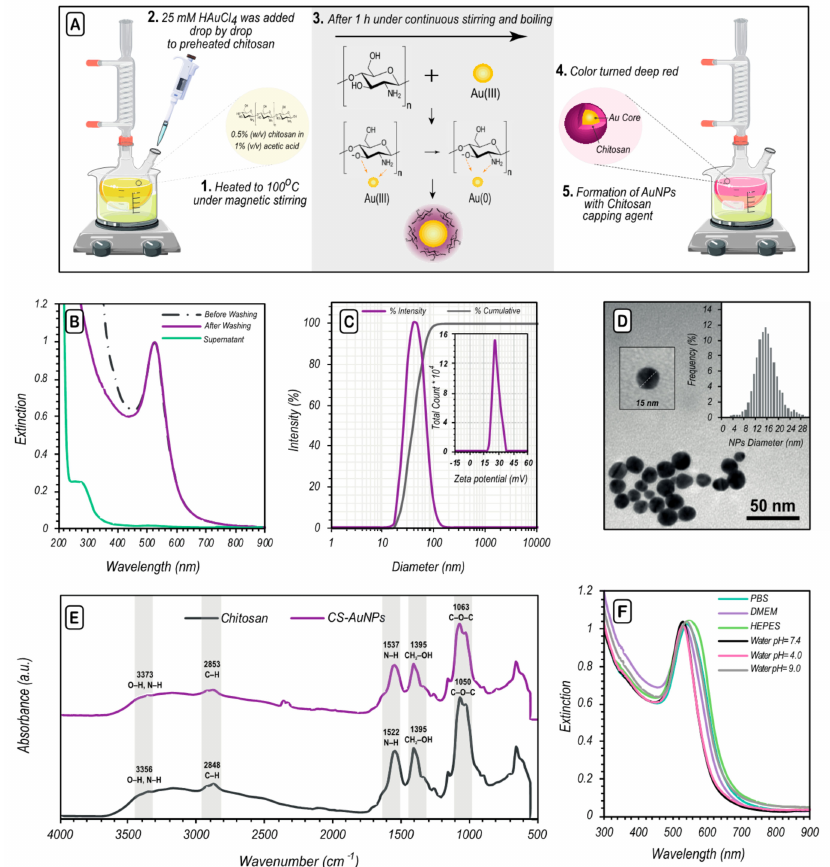
Figure 1. Characterization of Chitosan-capped AuNPs (CS-AuNPs), ( A ) Schematic representation of the synthesis of AuNPs using chitosan as a capping and reducing agent. ( B ) UV-Vis spectra of CS-AuNPs before and after washing of unreacted chitosan by centrifugation. ( C ) Representative hydrodynamic size distribution of CS-AuNPs, measured by DLS. The grey curve is the corresponding cumulative distribution. The inset shows the zeta potential distribution. ( D ) TEM images of CS- AuNPs confirming the formation of spherical nanoparticles, which were faceted (inset). The size dis- tribution from measuring >800 nanoparticles revealed an average particle core size of 15.0 ± 0.5 nm. ( E ) FTIR spectra of Chitosan and CS-AuNPs, confirming successful capping of the NPs by Chitosan. ( F ) UV-Vis spectra of CS-AuNPs in different media and pH conditions as indicated in the